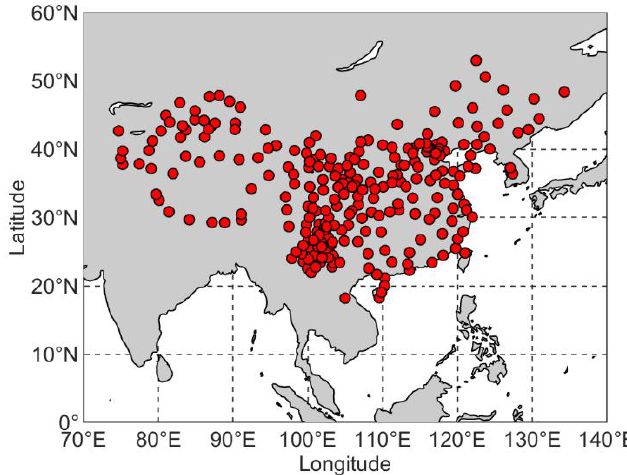
Figure 2. Geographic distribution of the 251 GNSS stations.